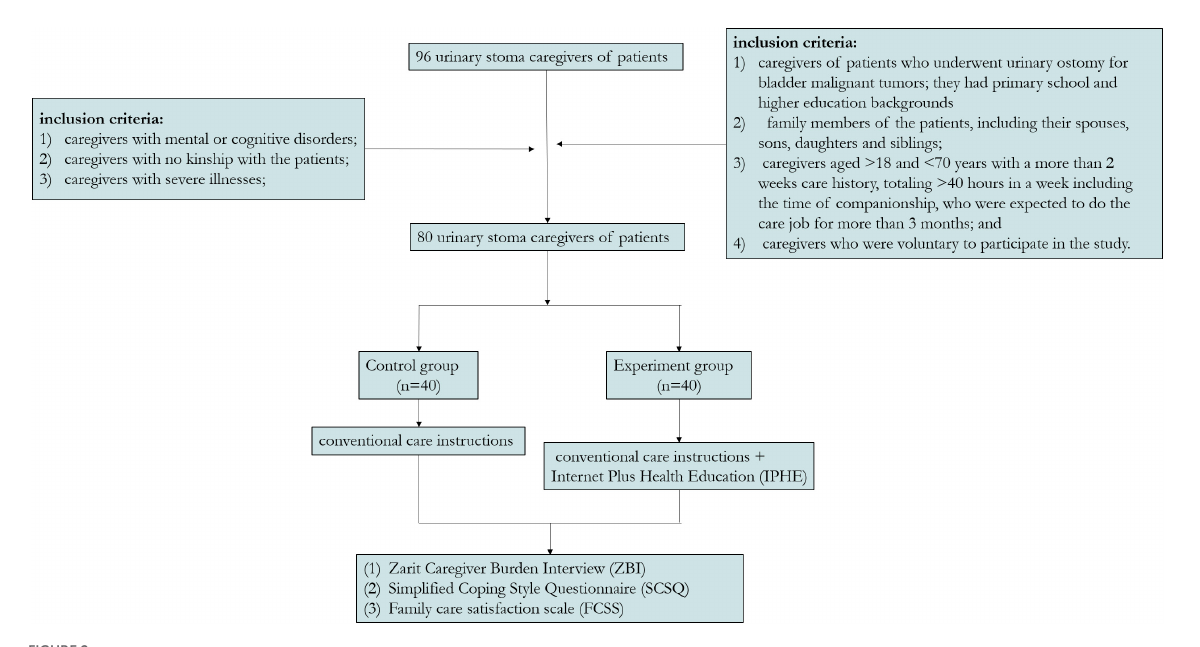
FIGURE2 The implementation steps of this